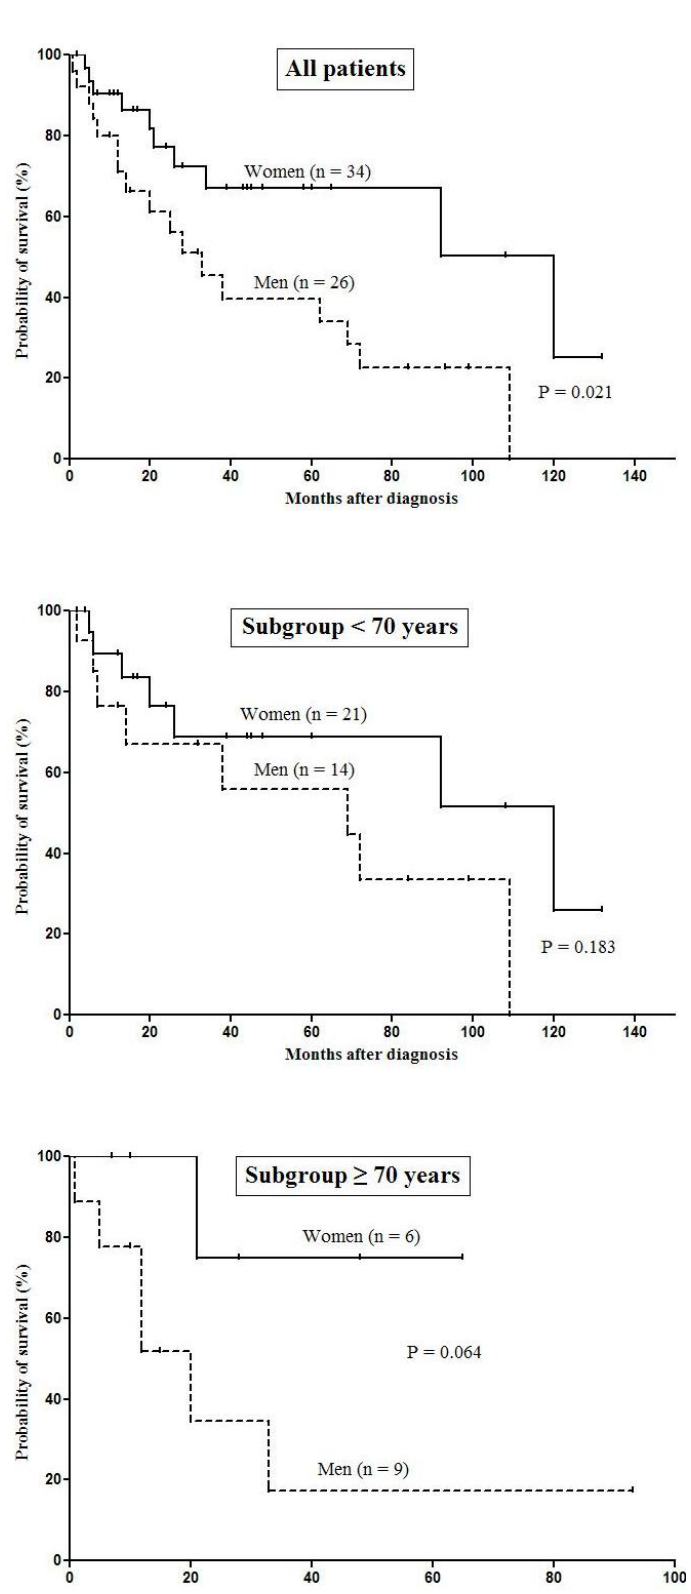
FIGURE 2. Influence of gender on survival of all patients and two subgroups based on